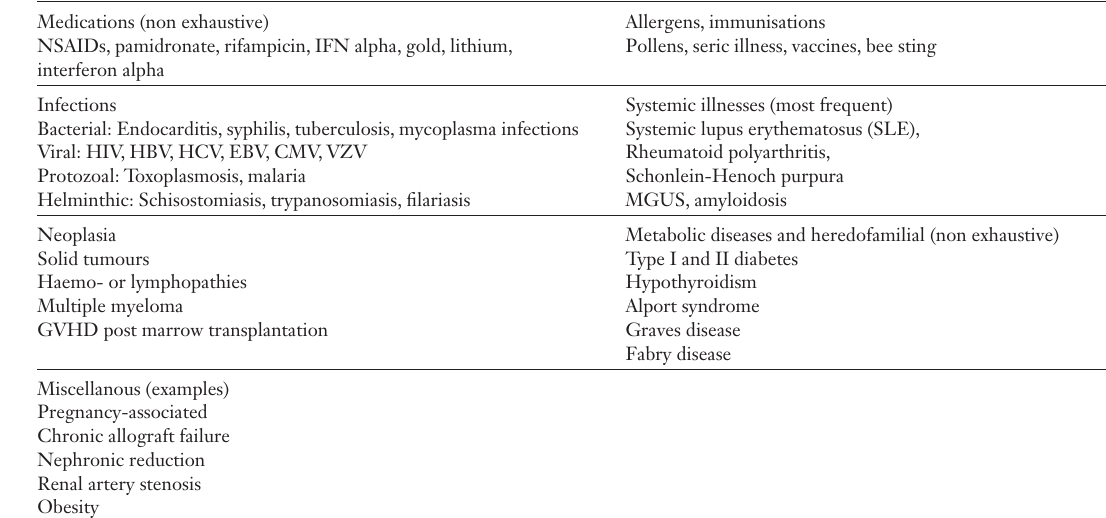
Miscellanous (examples) Pregnancy-associated Chronic allograft failure Nephronic reduction